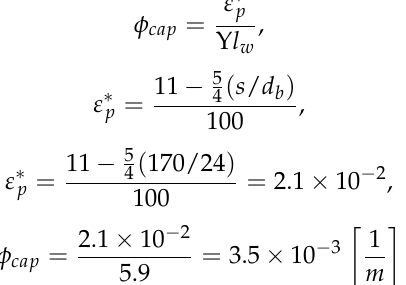
Figure A1. The modified UCSD shear capacity calculated for 4-story case study building. Lack of sufficient restraint provided by transversal reinforcement ( s / d b > 6), cyclic loading, and strains larger than yield are among the parameters that limit the curvature capacity. The curvature capacity can be computed as illustrated in Equation (33) [3]. Indeed, the curvature capacity is a function of the maximum strain experienced by vertical rebar that is calculated as illustrated in Equation (32). In the case of the 4-story RC wall, transversal reinforcement spacing (s) and longitudinal rebar diameter (d b ) are assumed equal to (approximately) 170 and 24 mm, respectively. Hence, the curvature capacity is computed as